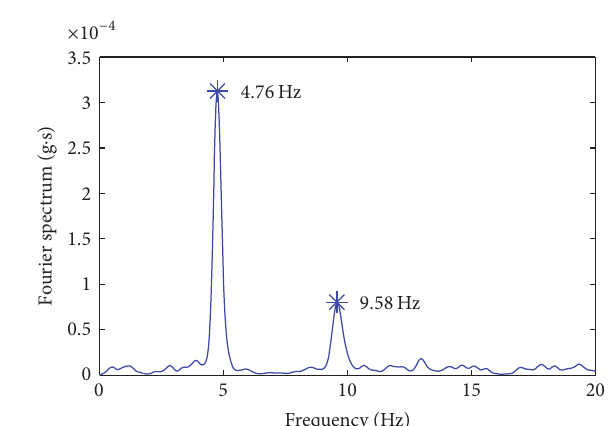
Figure 11: Seismic wave used in the test.